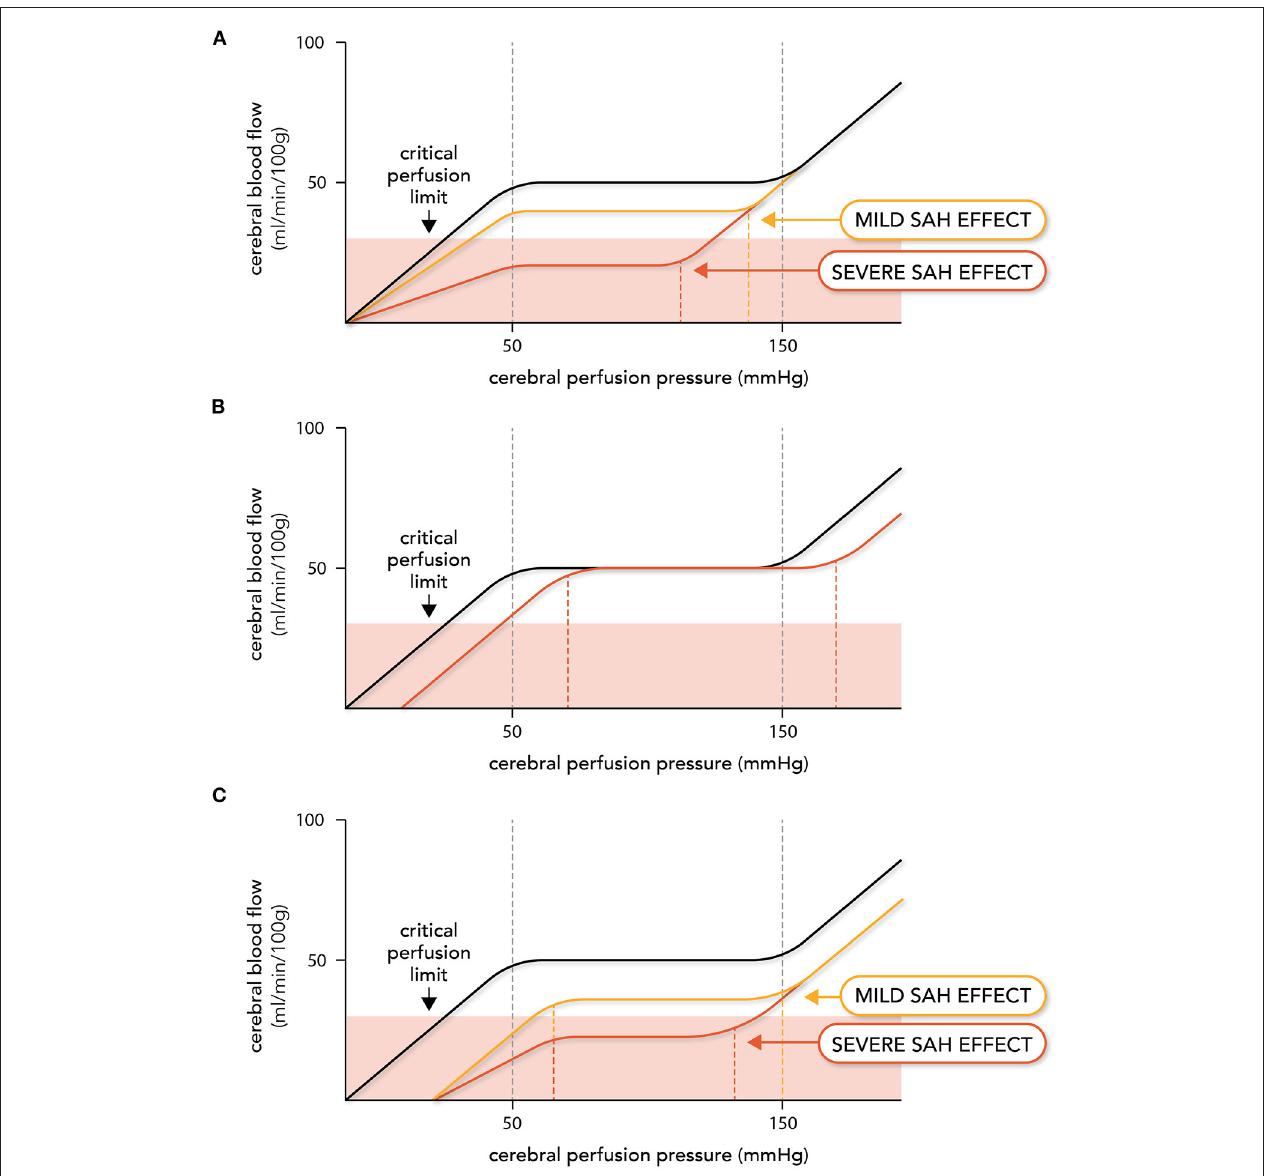
FIGURE 2 | Expected effects of subarachnoid hemorrhage on autoregulation. Altered vascular reactivity in subarachnoid hemorrhage (SAH) can have three hypothetical effects on cerebral autoregulation. Note that in this figure, cerebral autoregulation is plotted as the relationship between cerebral blood flow (CBF) and cerebral perfusion pressure (i.e., the difference between mean arterial pressure and intracranial pressure): this was done because intracranial pressure varies in SAH patients, thereby adding a variable to consider when relating CBF to mean arterial pressure in this pathological setting. The autoregulation curve in black represents the normal, non-pathological situation, while the red and yellow lines represent altered autoregulation. In (A) , augmented myogenic reactivity (i.e., microvascular constriction) reduces perfusion, shifts the upper limit of autoregulation leftward and narrows the autoregulatory range. In severe cases, cerebral blood flow drops below the critical perfusion limit. In (B) , upstream large artery constriction (i.e., angiographic vasospasm) reduces the perfusion pressure entering the microcirculation. This stimulates a right-ward shift in the autoregulatory curve, but perfusion deficits do not occur until the new lower limit is reached. In (C) , both microvascular and larger artery constriction occur, creating a hybrid of (A) and (B)